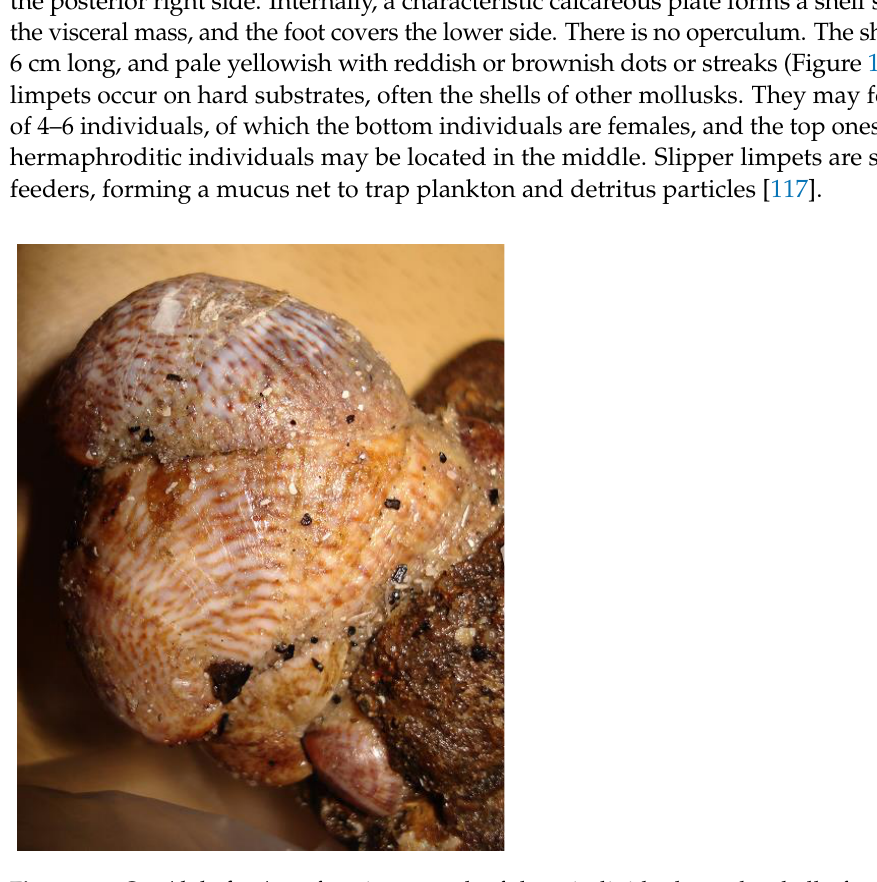
Figure 12. Crepidula fornicata forming a stack of three individuals on the shell of a whelk, Buccinum undatum . Specimens were collected at low tide at Rømø, Wadden Sea in September 2007. Photo: K.R. Jensen.